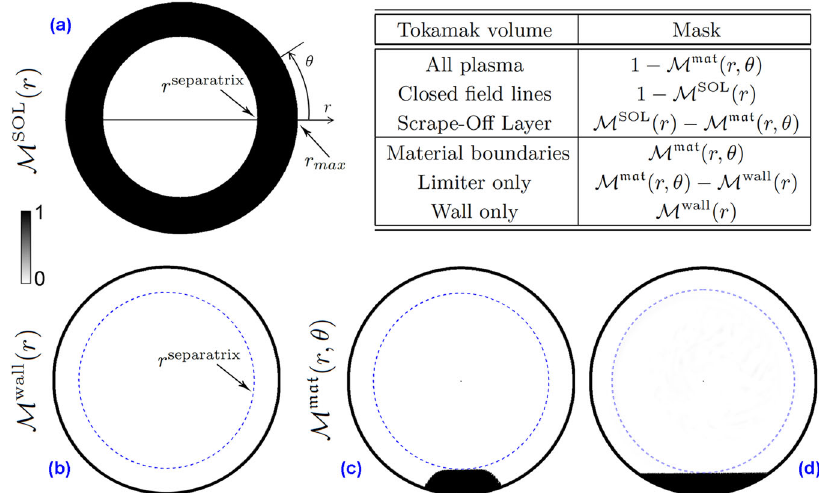
Fig. 6 The various masks used for penalisation in the gyrokinetic-quasineutrality system. The resolved domain spans from the very core r / a = 0 to the outer wall region at r / a = r max = 1.3 ( a ). The outer wall is circular and within 1.25 ≤ r / a ≤ 1.3 ( b ). The minimum radius where mask M mat ð r ; θ Þ ¼ 1 the location of the magnetic separatrix at r / a = r separatrix = 1. An appealing aspect of penalisation is the ease with which the shape of masks (i.e., the geometry of the material boundaries) can be altered. Two examples are shown in c , d ; all limiter computations shown here are performed in geometry ( d ).